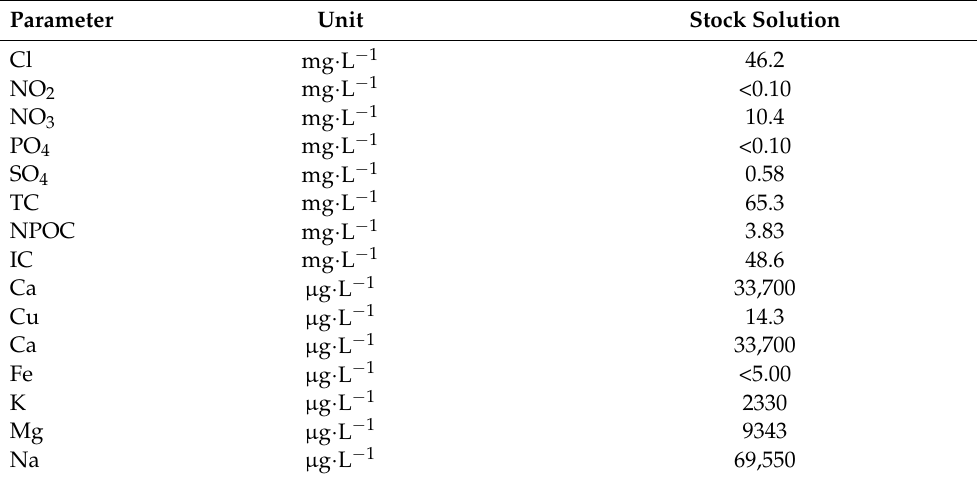
Table A1. Chemical composition of the MPs mixture in tap